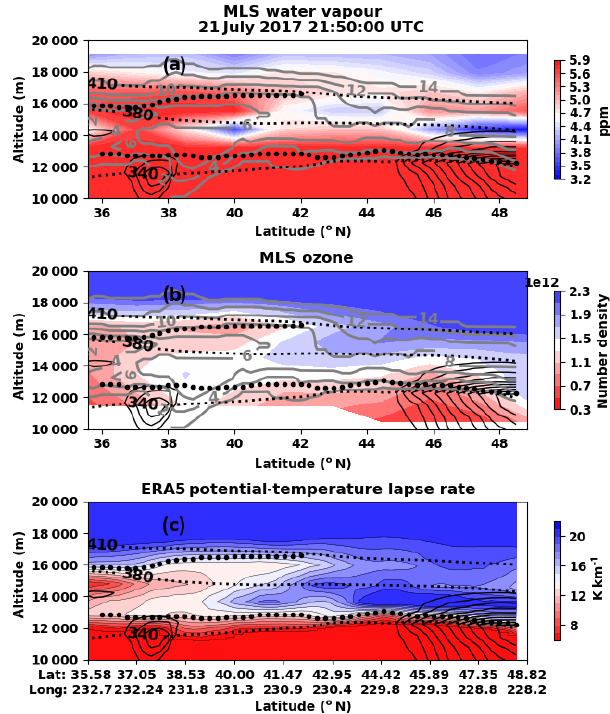
Figure 7. MLS-measured water vapour profile (a) , ozone (b) , and the potential-temperature lapse rate determined from the ERA5 re- analysis for the 22:00UTC time step along the MLS measurement track (c)